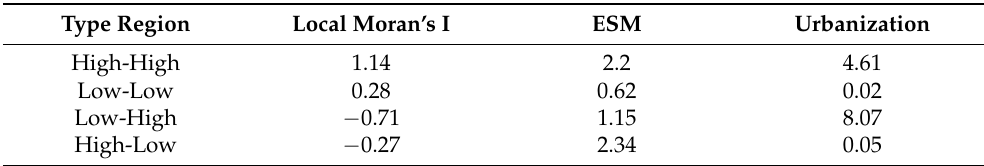
Table 4. The mean values of local Moran’s I, ecosystem service multifunctionality (ESM), and urbanization in four types regions.